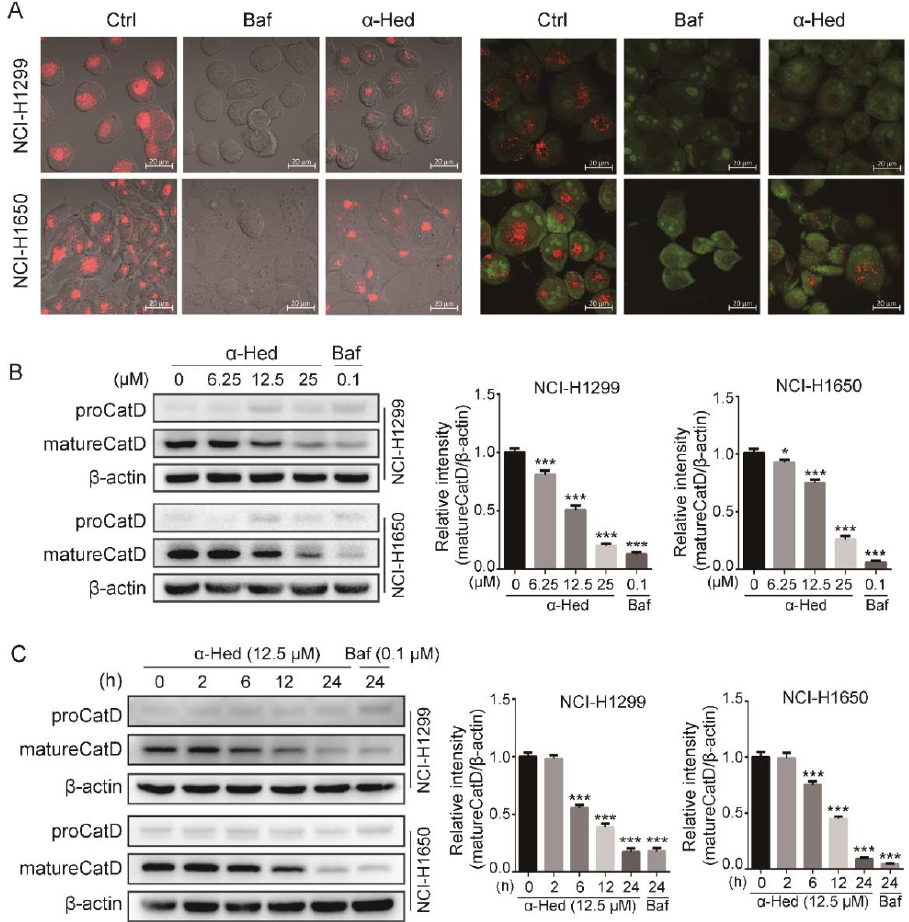
Figure 3. α -Hed altered the lysosomal pH and inhibited lysosomal cathepsin maturation. ( A ) α -Hed altered the lysosomal pH. Cells were treated with vehicle, α -Hed (12.5 µ M), or Baf (0.1 µ M) for 24 h. ( B , C ) α -Hed promoted mature cathepsin D (CatD) accumulation in a dose- and time-dependent manner. NCI-H1299 and NCI-H1650 cells were treated with α -Hed (12.5 µ M) or Baf (0.1 µ M) for the indicated time courses ( C ), or treated with α -Hed or Baf at the indicated doses for 24 h ( B ). Mature CatD was quantified and the fold increase is presented. * p < 0.05, *** p < 0.001.